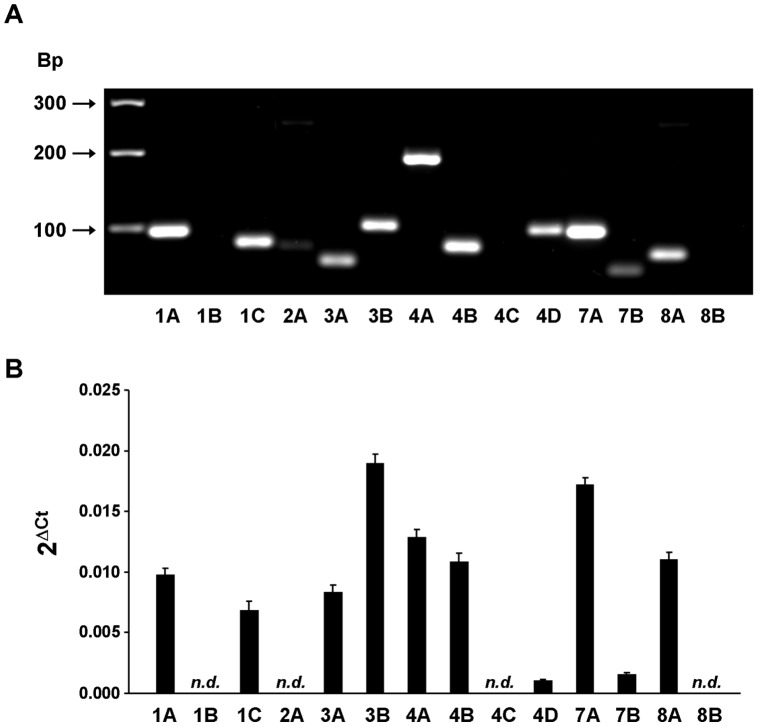
Expression analysis of mRNA encoding cAMP-PDE isoforms in RASMCs.RT-qPCR reactions were carried out on mRNAs isolated from RASMCs. The expression of PDE1A (1A), PDE1B (1B), PDE1C (1C), PDE2A (2A), PDE3A (3A), PDE3B (3B), PDE4A (4A), PDE4B (4B), PDE4C (4C), PDE4D (4D), PDE7A (7A), PDE7B (7B), PDE8A (8A) and PDE8B (8B) was analyzed. A: PCR products were resolved by electrophoresis on a 3% agarose gel. Shown is the picture of a representative gel stained with GelRed®. Position of molecular weight markers is indicated in base pairs (Bp). B: mRNA expression was expressed using the 2ΔCt method as described in Materials and methods. Data are mean±SEM of 9 experiments. n.d. not detectable.